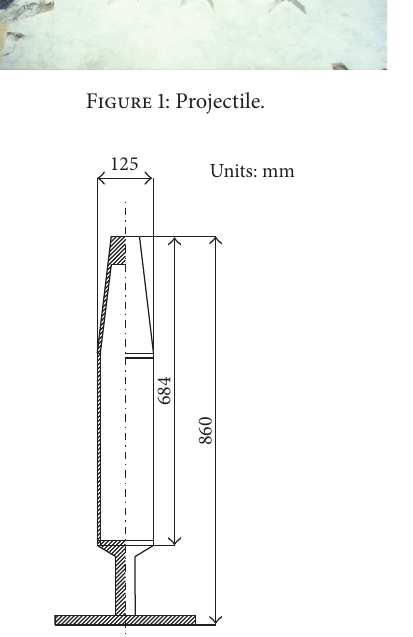
Figure 3: Diagram of reinforced concrete targets.